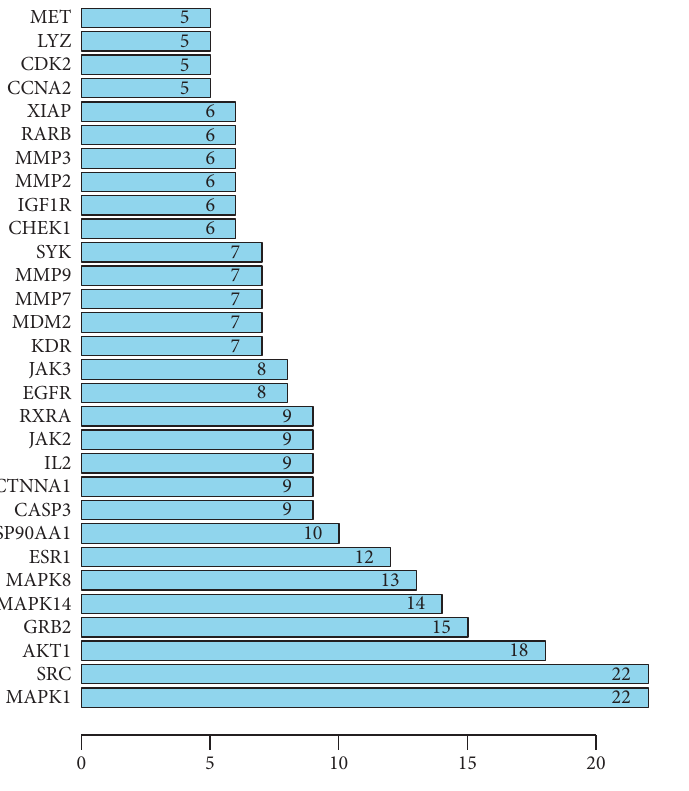
Figure 4: The intersection targets in PPI network diagram.